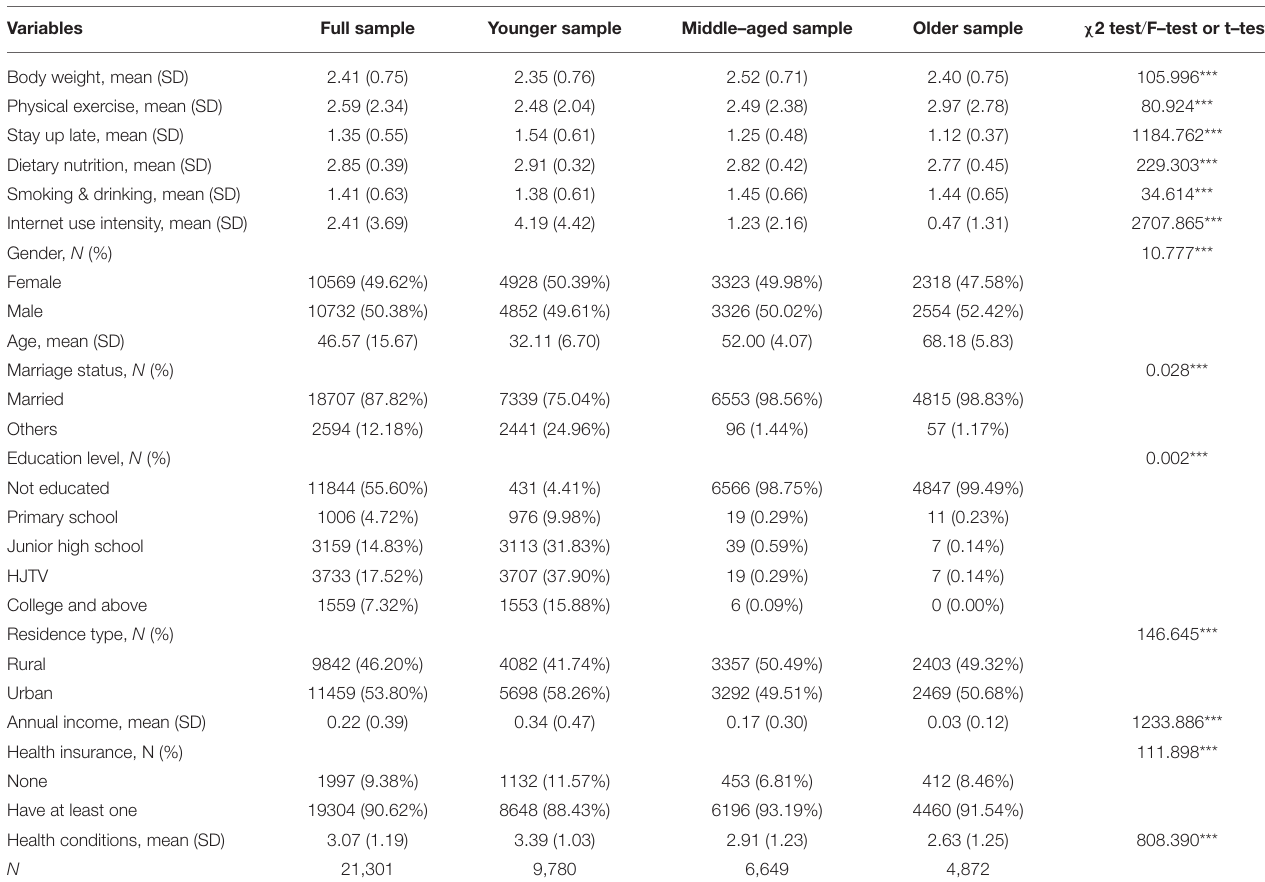
TABLE 1 | Descriptive statistics of all variables ( N = 21,301).